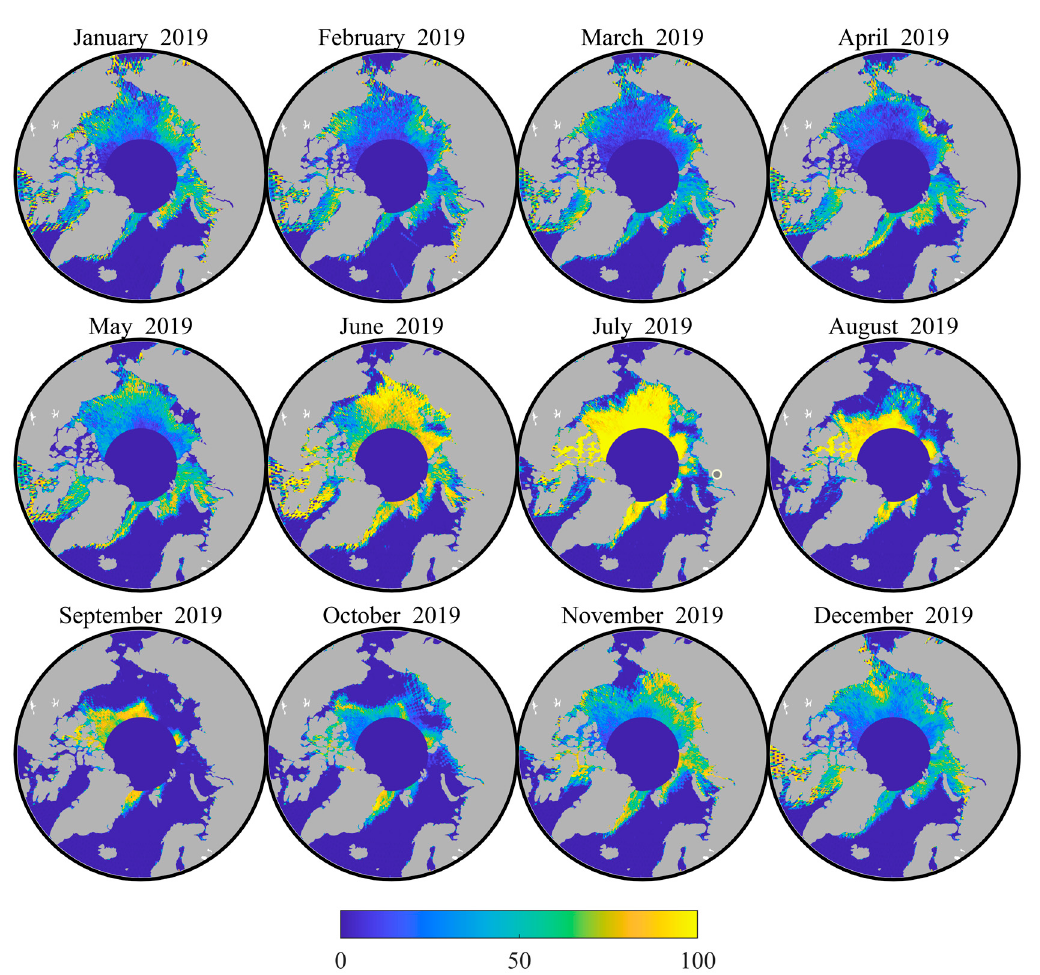
Figure 16. Lead fractions from 2019 based on the HY-2B radar altimeter data and trained Bagging classifier.